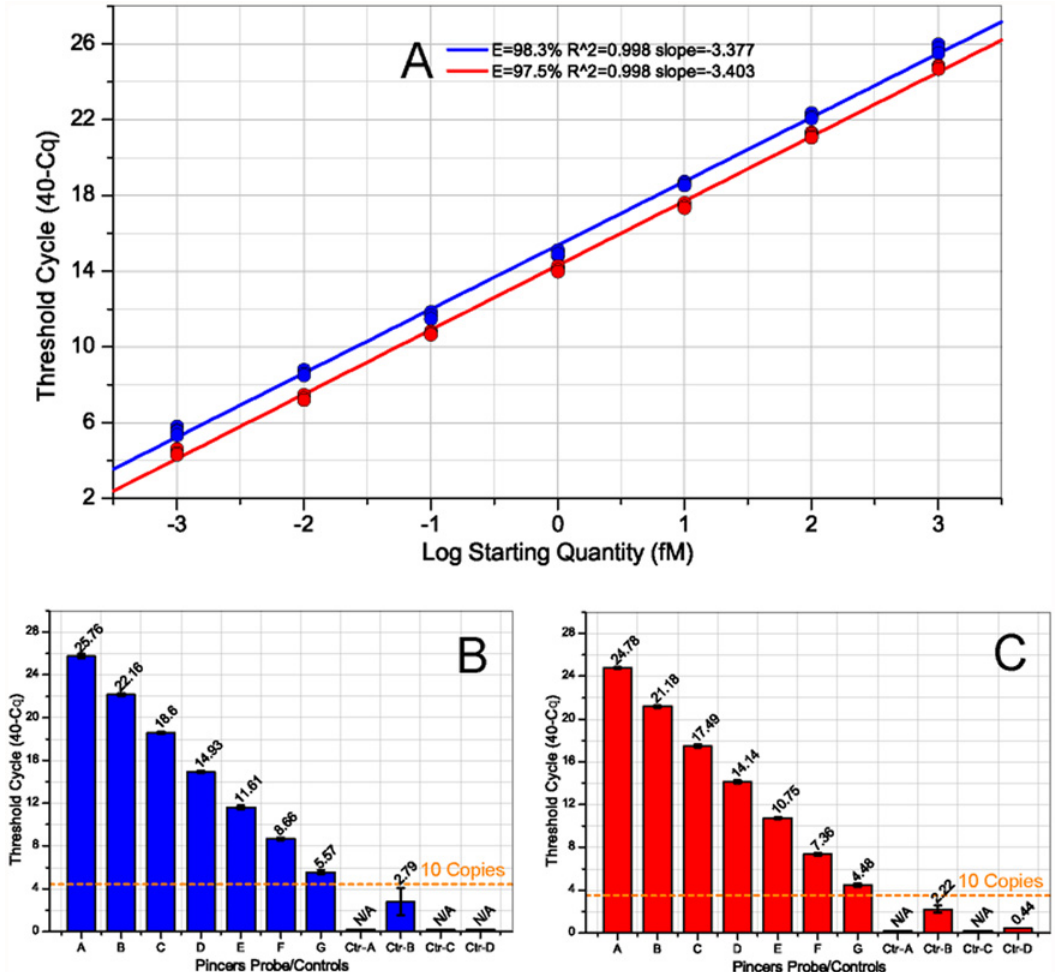
Fig 3. Dynamic range, specificity, and sensitivity of the pincer probe-based miRNA quantification assay. Plot A shows the correlation between the miRNA input and the Cq (threshold of cycle) values in the test assays which in the absence or presence of total RNA (Spike-In test). Plots B and C show the Cq values from the test assays using perfectly matched pincer probes or control pincer probes. The synthetic miRNA input ranged from 1.0 X 10 -3 fM (about 60 copies per reaction) to 1.0 X 10 3 fM in the PCR (lane A to G, perfectly matched pincer probes). The amount of synthetic miRNA for the four pincer-probe control test assays (Ctr-A to Ctr-D) was 10 pmol. The total RNA input for the Spike-In test assay was 1 μ g. The amplification chart and raw data are available in S1